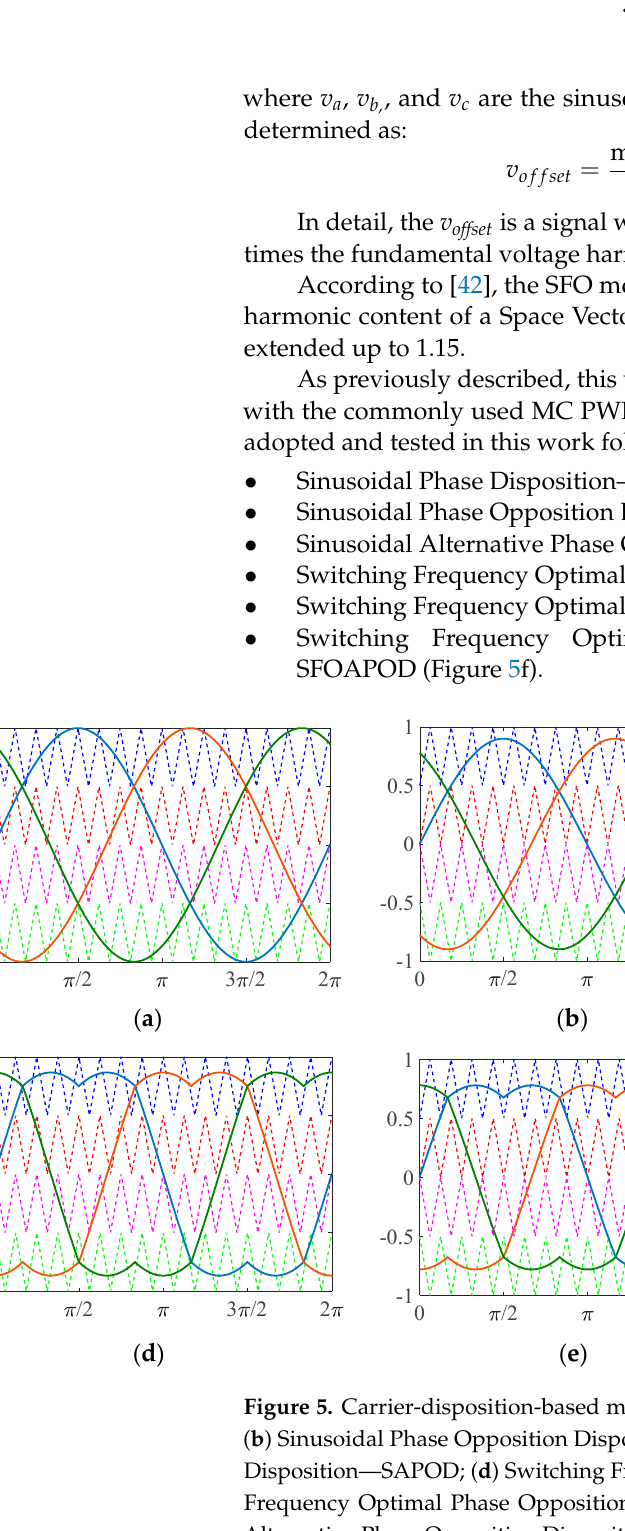
Figure 4. Modulation signals with modulation index equal to 1: ( a ) sinusoidal; ( b ) Switching Fre ‐ quency Optimal—SFO.